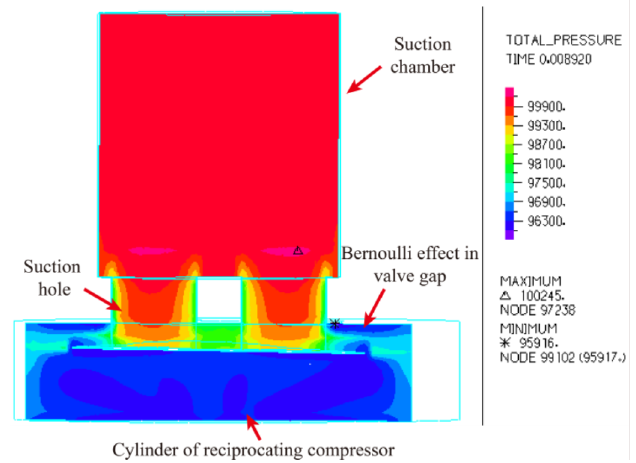
Figure 12. The pressure distribution along the Y